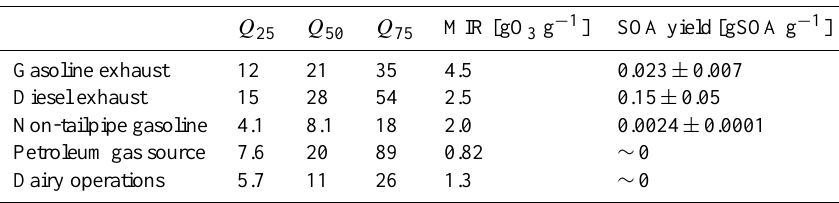
Table 6. Quartiles [ppbC] for ambient concentrations from major petroleum-based sources measured at the Bakersfield site (does not include methane emissions) shown with average maximum incremental reactivity (MIR) values and secondary organic aerosol (SOA) yields for each